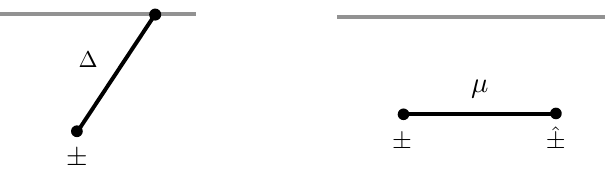
Figure 2. Left: diagrammatic representation of the bulk-to-boundary propagator (2.14) in dS where the point in the bulk sits in the ± branch of the in-in contour. Right: bulk-to-bulk propagator in dS for a field of mass (2.17), where one bulk point sits on the ± branch of the in-in contour and the other on the ˆ ±